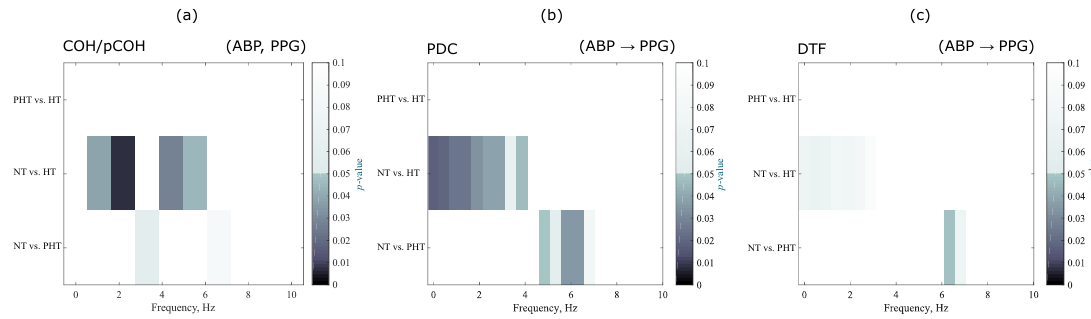
Figure 4. Frequency significance in differentiation blood pressure groups: ( a ) COH and pCOH ( b ) PDC direction ABP → PPG; and ( c ) DTF direction ABP → PPG. Abbreviations: NT, normotensive;